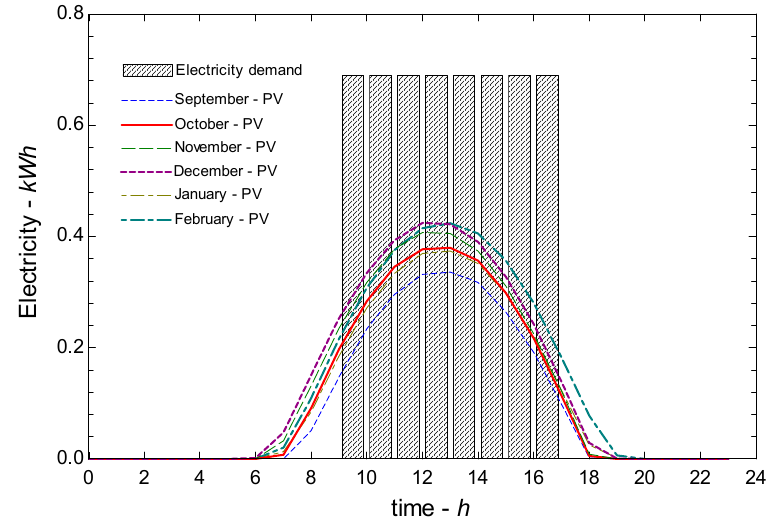
Figure 4. Daily energetic performance of EU 1 on a day with irrigation (on-grid PV system).